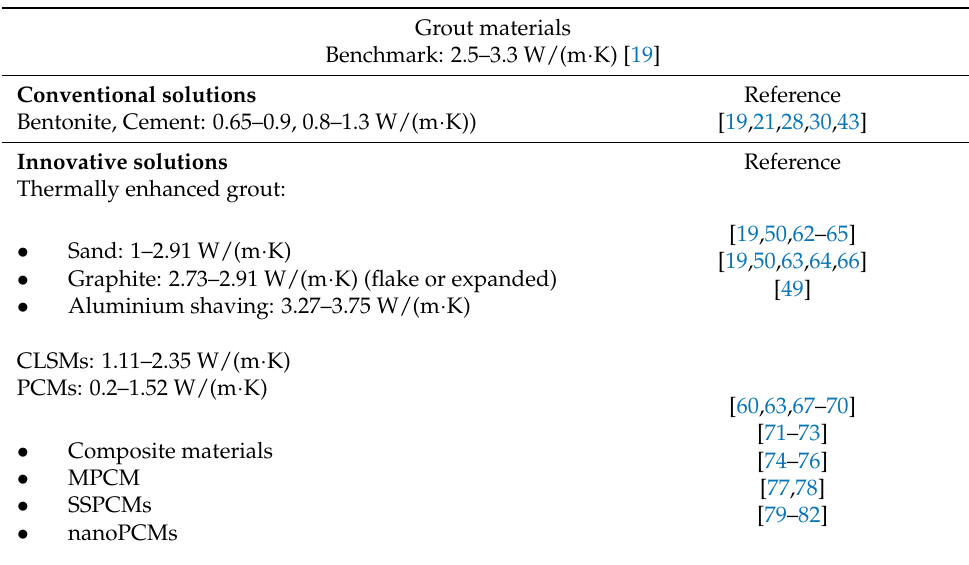
Table 2. Conventional and innovative grout materials in GCHP systems with corresponding ther- mal